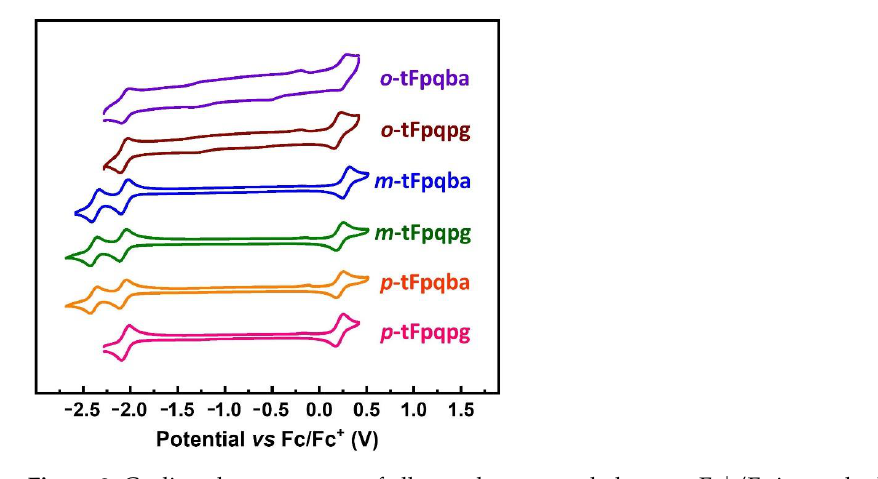
Figure 2. Cyclic voltammograms of all complexes recorded versus Fc + /Fc in newly distilled DMF solution with 0.1 M n -Bu 4 NPF 6 supporting electrolyte and the scan rate being set to 100 mV s − 1 . Table 2. Electrochemical and thermal data of all new complexes.